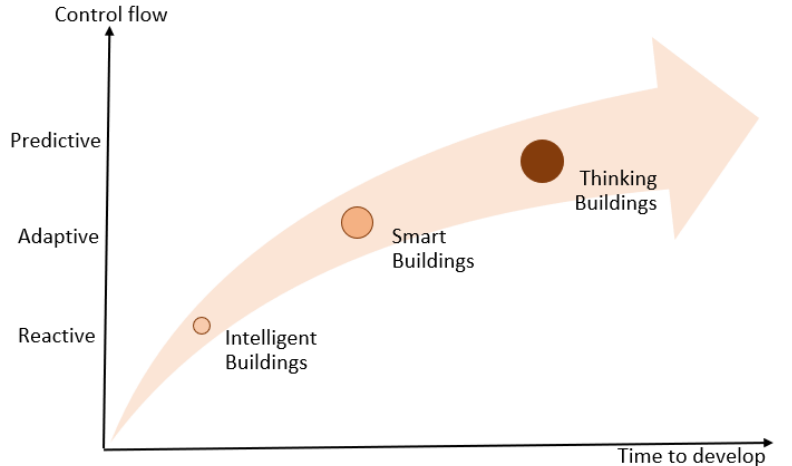
Figure 1. Building concept development throughout time based on the most cutting-edge knowledge and technology